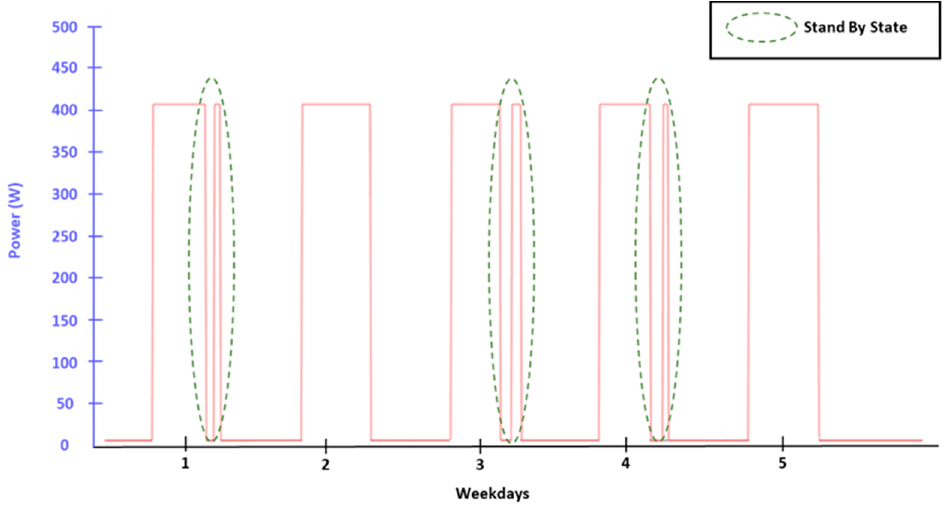
Figure 16. Business processes and lighting consumption flexibility.